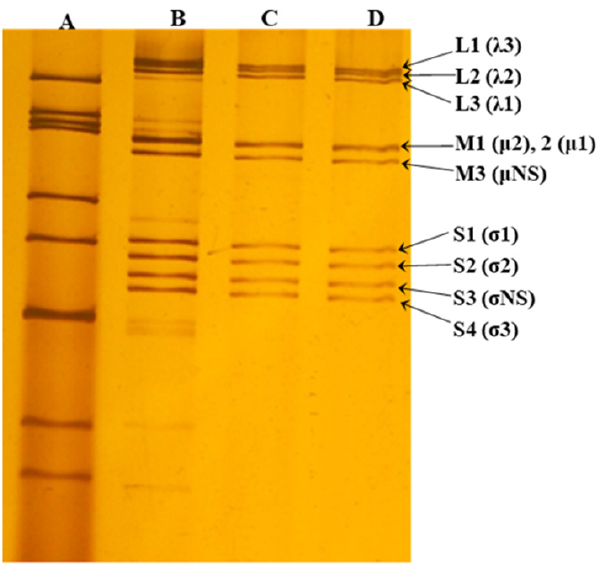
Figure 1. Polyacrylamide gel electrophoresis (PAGE) analysis of MRV dsRNA. PAGE of three strains isolated from intestinal contents of two alpacas (SA44 and H8) and one llama (SL7) in MA-104 cell line showing the 10 characteristic genomic segments of MRV: (A) SA-11 RVA strain exhibiting the typical 4–2–3–2 pattern (11 segments of dsRNA); (B) SA44 strain isolated showing a coinfection of RVA (11 genomic segments) and MRV (10 genomic segments); (C and D) strains H8 and SL7 exhibiting MRV monoinfection, showing the 10 dsRNA segments characteristic of MRV. Each segment of dsRNA is classified by size: genes L1–L3 (large segments), M1–M3 (medium segments) and S1–S4 (short segments) encode the proteins λ 3– λ 1, µ 2- µ NS, and σ 1– σ 3,